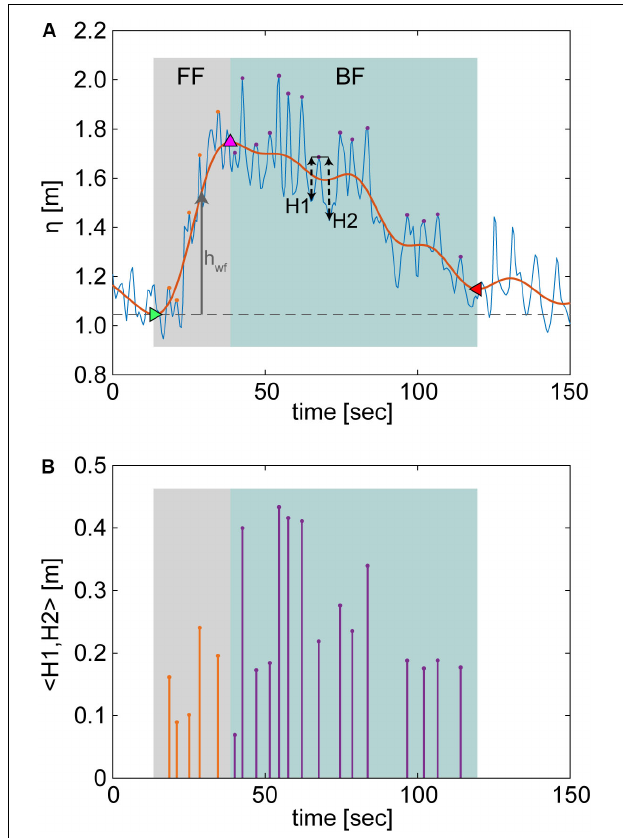
FIGURE 2 | Individual infragravity (IG) waves evaluated for different waveform geometries and characteristics. (A) An example IG wave with full water level (blue line) and the IG waveform (orange line), with the leading trough (green triangle), peak (pink triangle), and trailing trough (red triangle) of the waveform also indicated. For each IG wave over 0.05 m in trough-to-peak height, we cataloged the number and heights of each of the short-period waves riding on the front face (“FF”) and back face (“BF”) sections and the corresponding IG waveform height ( h wf , gray arrow) above the leading trough water level (gray dashed line) for each of these secondary waves. The secondary short-period wave heights were found by averaging the vertical distances from the peak to the leading (“H1”) and trailing troughs (“H2”). Only secondary waves with periods > 1.5 s and mean heights > 0.05 m were considered. The resulting secondary wave heights for the example are shown in (B) for both the FF (orange stems) and BF (purple stems).